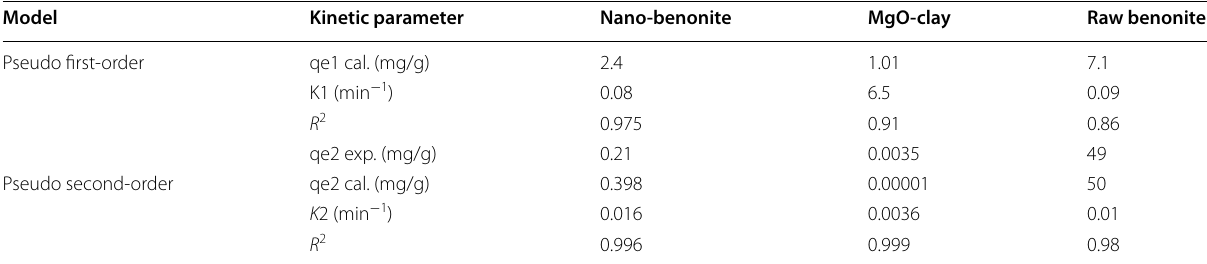
Table 5 Kinetic parameters for the adsorption MG onto nano-bentonite, MgO impregnated clay and raw bentonite